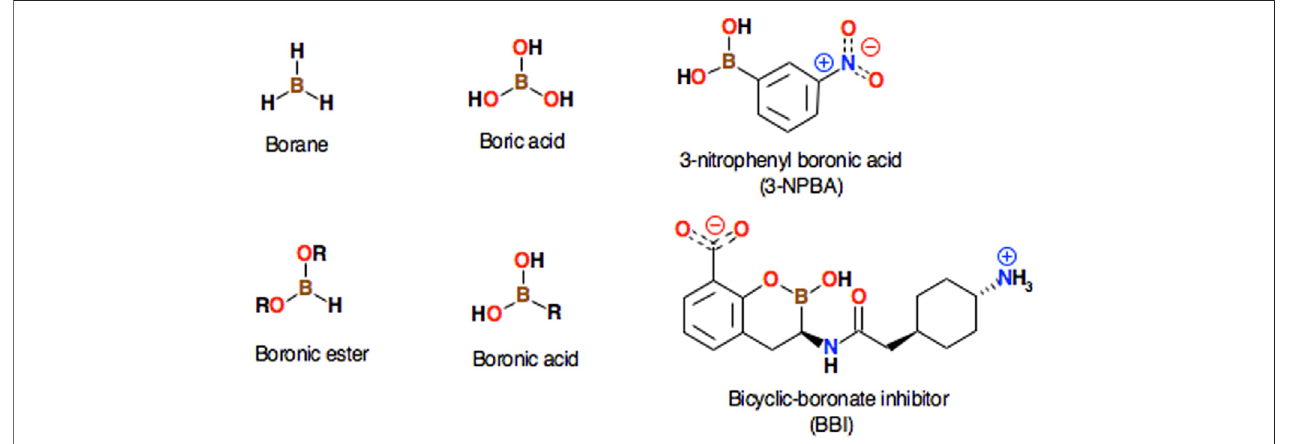
FIGURE 1 | Several well-known simple borane compounds are shown along with their systematic names. The structures of 3-nitrophenylboronic acid (3-NPBA) and the bicyclic boronate inhibitor ((3R)-3-[[2-[4-(amino)cyclohexyl]acetyl]amino]-2-hydroxy-3,4-dihydro-1,2-benzoxaborinine-8-carboxylic acid, BBI), which are the subject of this study, are also